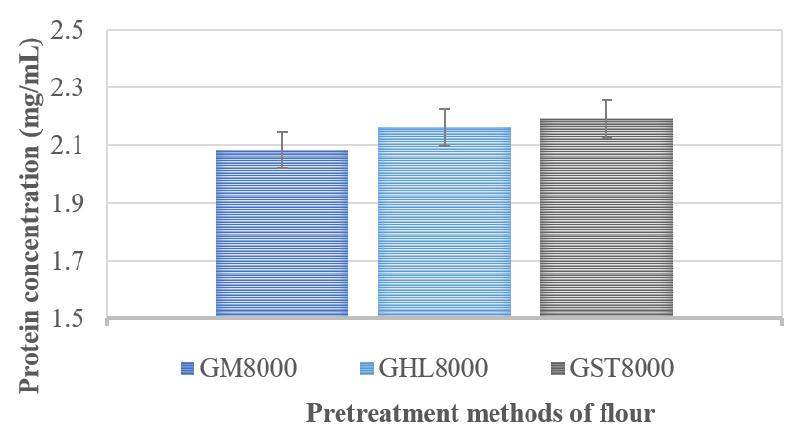
Pretreatment methods of flour influence on protein concentration; GM8000—graham flour prestored at room temperature, GHL8000—graham flour prestored in refrigerator at 4 °C, and GST8000—graham flour prestored at room temperature with glass beads.